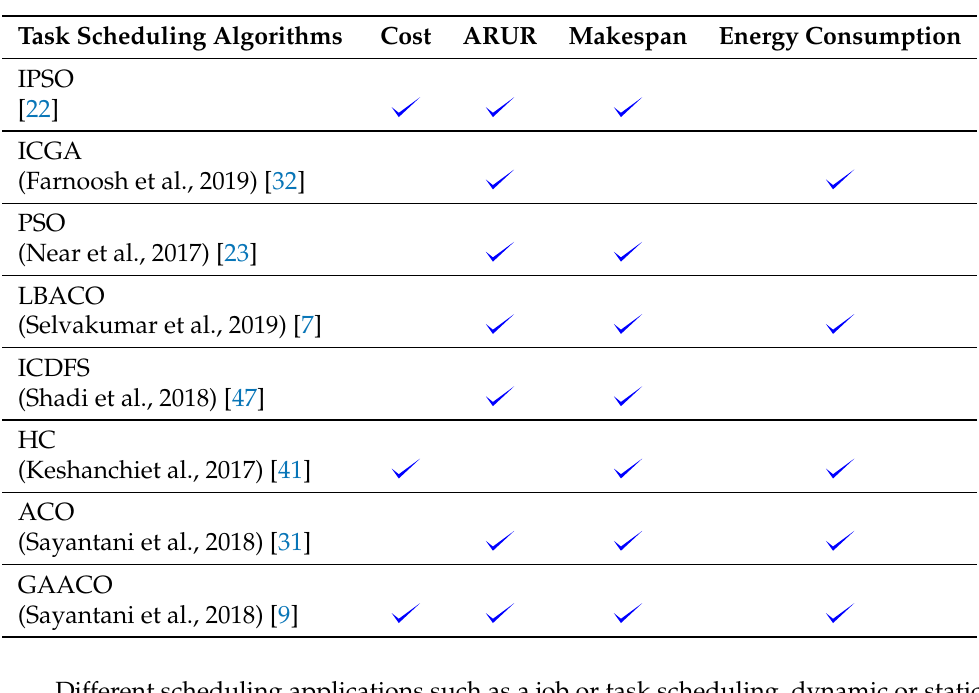
Table 1. Comparison of task scheduling